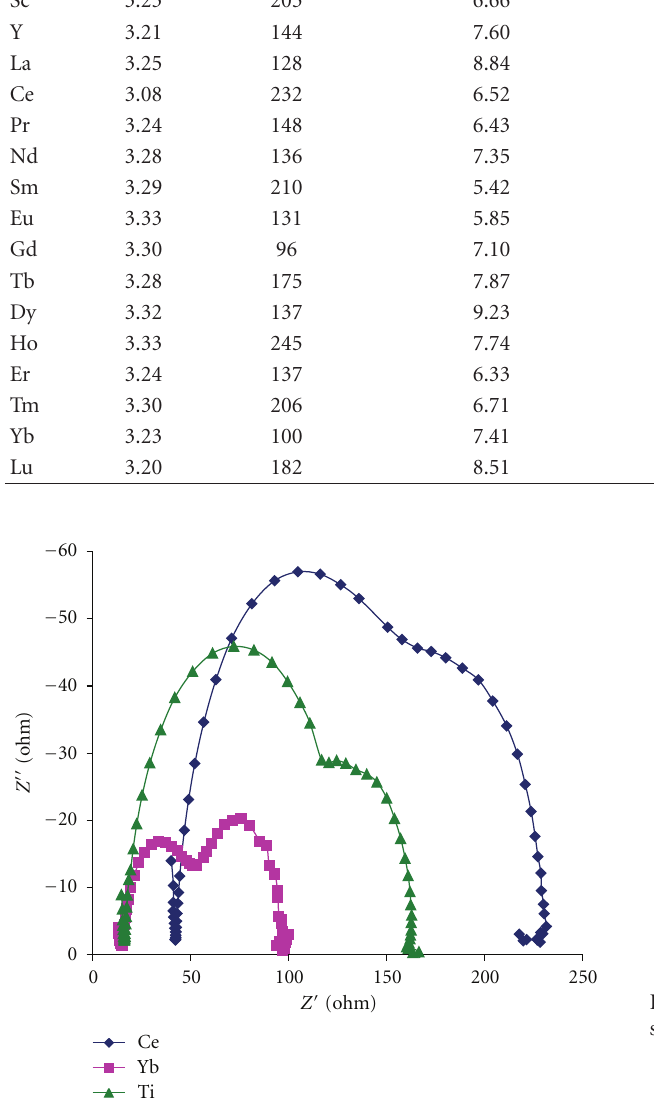
Figure 4: Electrochemical impedance analysis Nyquist Plots of two selected RE cells and Ti cell.